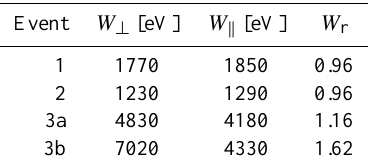
Table 3. Mean-particle theory results: perpendicular energy W ⊥ , parallel energy W k and perpendicular-to-parallel energy ratio W r